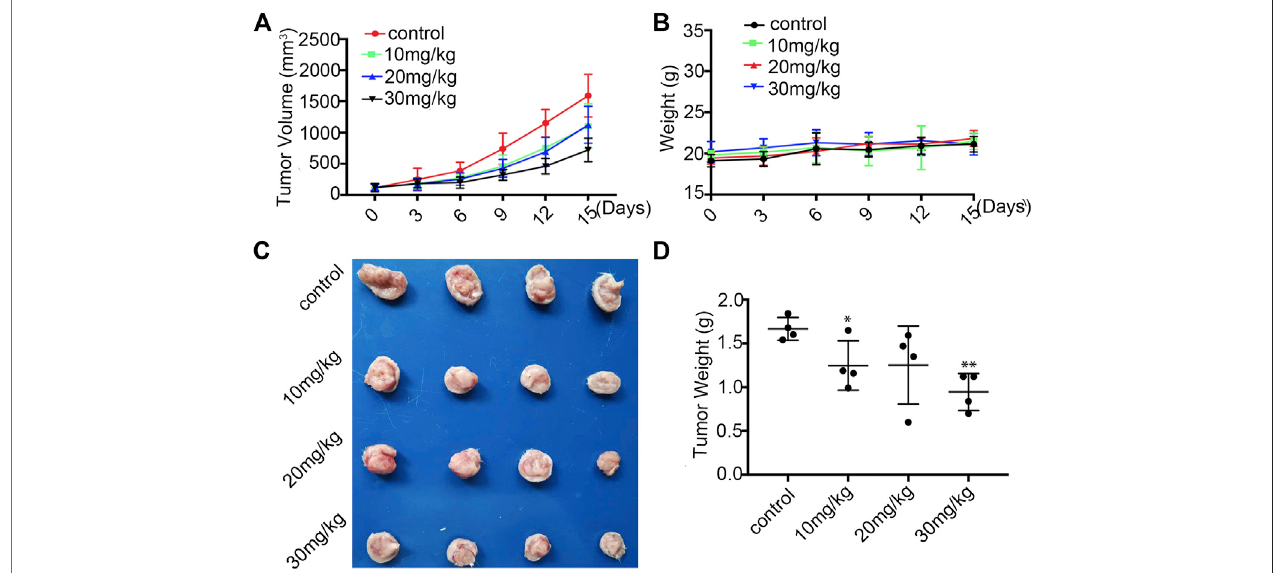
FIGURE 8 | Statmp-151 inhibited tumor growth in vivo. (A) In 4T1 mice model, the mice were treated with Statmp-151 (10, 20, and 30 mg/kg) or Control. Tumor volumesweremeasuredevery3 days. (B) Thebodyweightof4T1tumourmicewasmeasuredevery3 days. (C) Tumoursfrommice treatedwithindicatedStatmp-151 on the fi nal day (Day 15). (D) Tumors weight treated with Statmp-151 at the 15